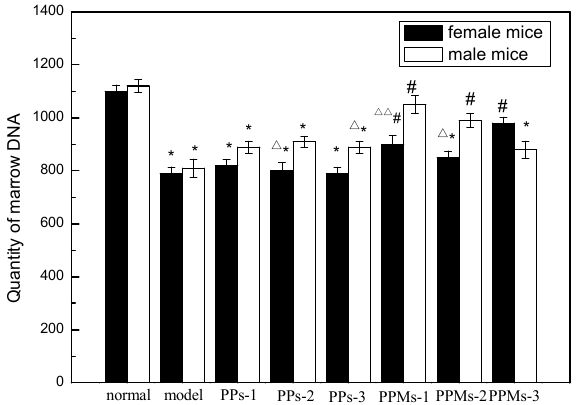
Figure 8. Effect of PP and PPM on quantity of marrow DNA; the irradiation dose was 6 Gy. * p < 0.05; # p < 0.05 compared with the model group; Δ p < 0.05 compared with the male group in the same indicator and ΔΔ p < 0.01 compared with the male group in the same indicator (mean ± SD, n = 6).